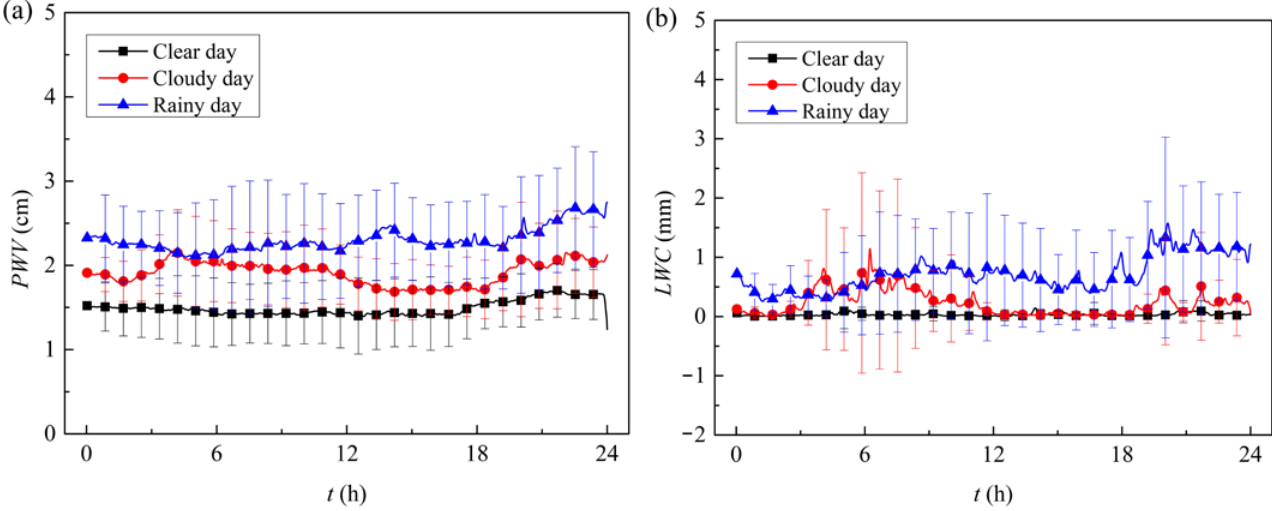
Figure 5. Statistical characteristics of vapor density and liquid water content (whole day, monsoon season) under different weather conditions. ( a ) Precipitable water vapor ( PWV ), ( b ) integrated liquid water content ( LWC ). The t (h) is expressed in UTC+8.